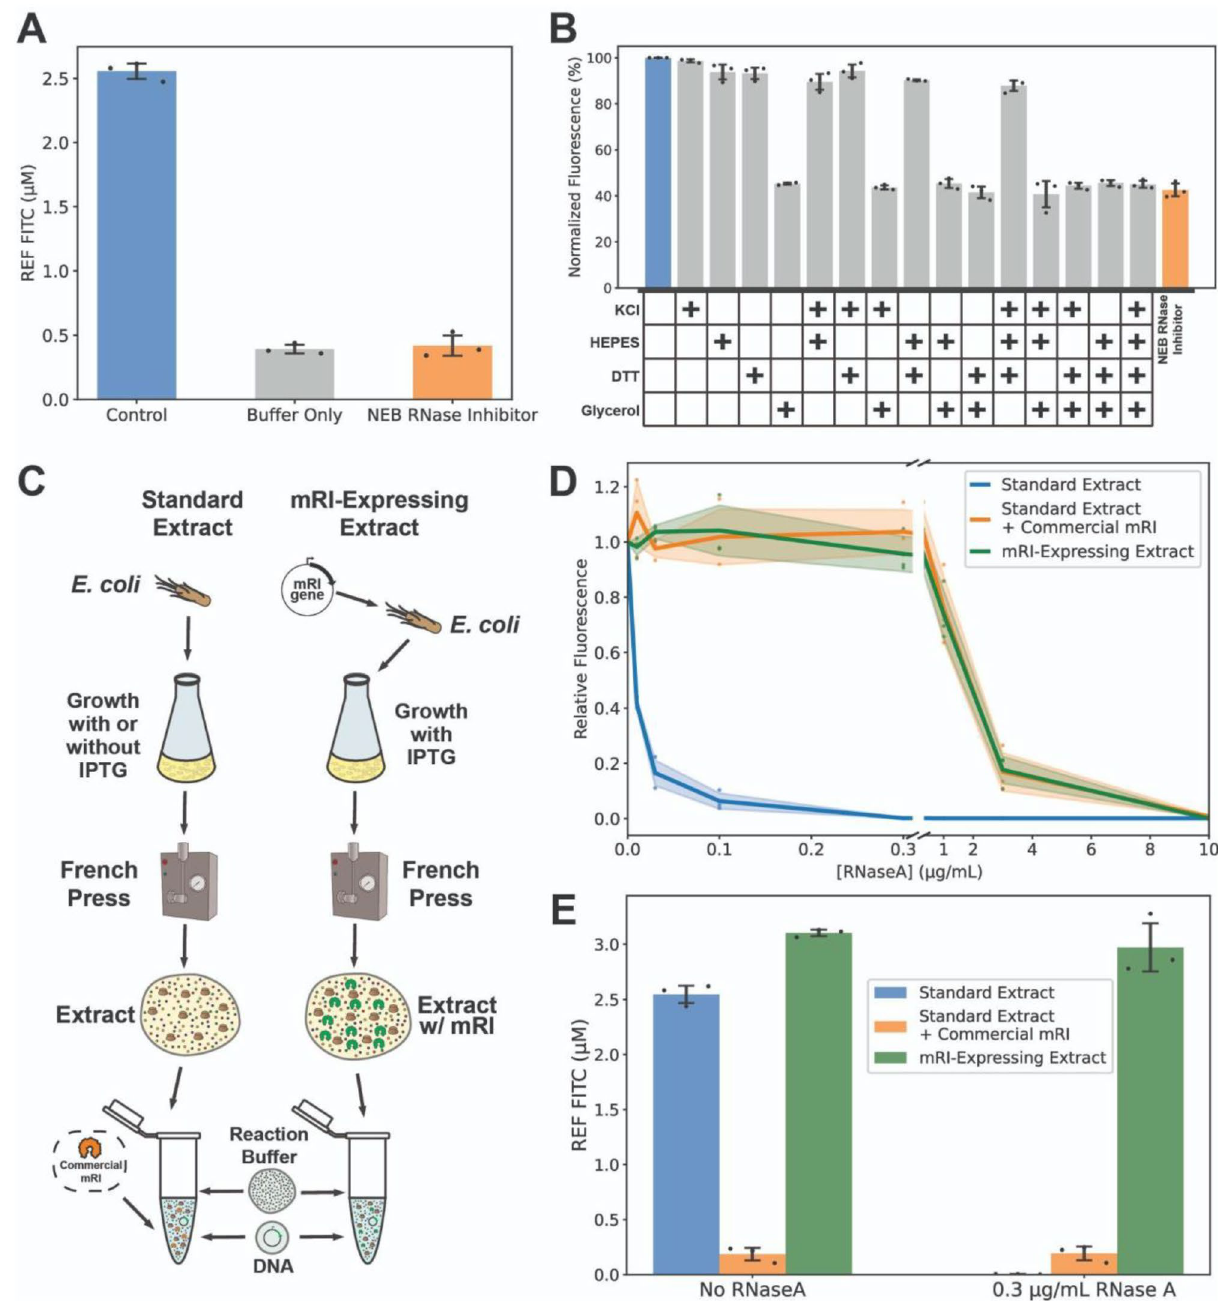
Figure 2. In situ RNase production recovers reporter production originally thwarted by glycerol. ( A ) sfGFP expression for the positive control (standard cell-free reaction mix) and in the presence of RNase inhibitor (mRI) or equivalent buffer concentration without mRI (50 mM KCl, 20 mM HEPES, 8 mM DTT, 50% glycerol). ( B ) Effect of individual and combined commercial buffer components on reporter output. ( C ) Scheme of cell- free extract production and reaction mix. mRI-expressing extract was obtained by cloning the murine RNase inhibitor gene under T7 promoter control. Purification and reaction preparation were equivalent to standard extract, but no additional mRI was required to perform cell-free measurements. ( D ) Relative expression of sfGFP in standard extract, standard extract with commercial RNase inhibitor, and mRI-expressing extract were challenged with an RNaseA concentration gradient. Data are normalized to the expression level with no RNaseA ( E ) Fluorescent intensity (relative equivalence of µM FITC) of standard extract with and without commercial mRI vs. mRI-expressing extract at 0 and 0.3 µg/mL RNaseA. Data in ( A ) are the mean of three technical replicates. Data in ( B , D , E ) are the mean of three experiments performed on three different days. Error bars or shaded areas correspond to ±